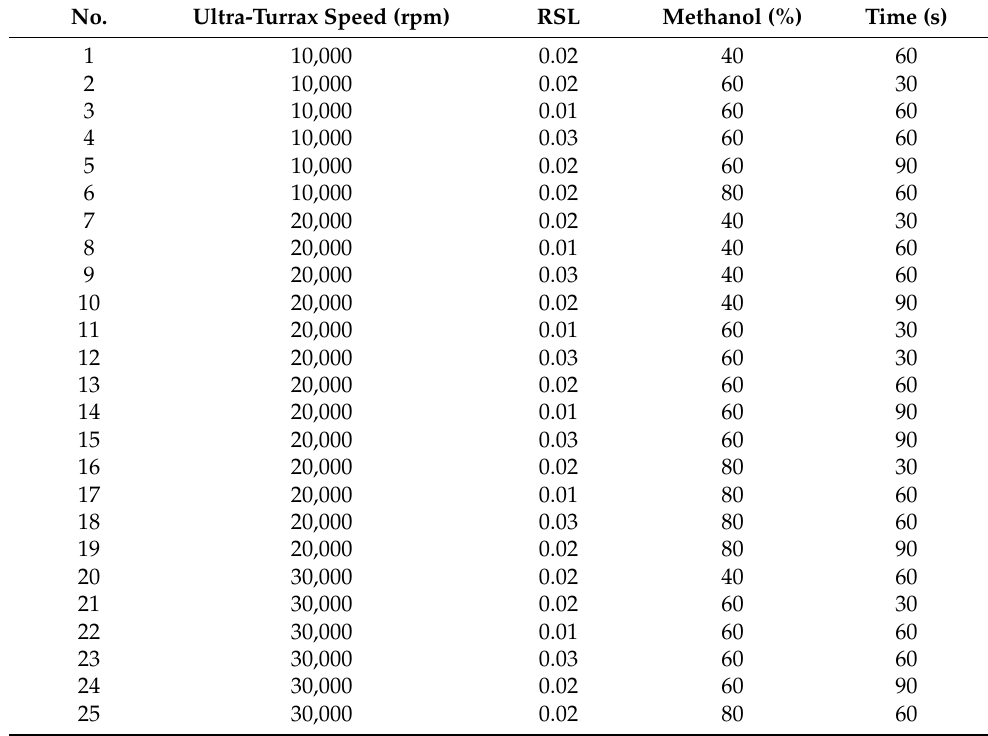
Table 1. Box–Behnken design of the TPC and TFC from amaranth seed.